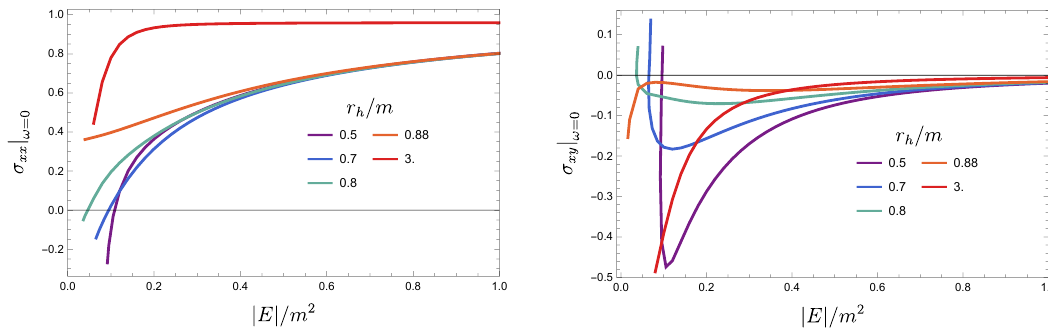
Figure 11 . DC conductivities as functions of | E | /m 2 for different values of r h /m at Ω /m = 1 . At high temperatures the conductivity tensor tends towards the identity σ xx = 1 and σ xy = 0